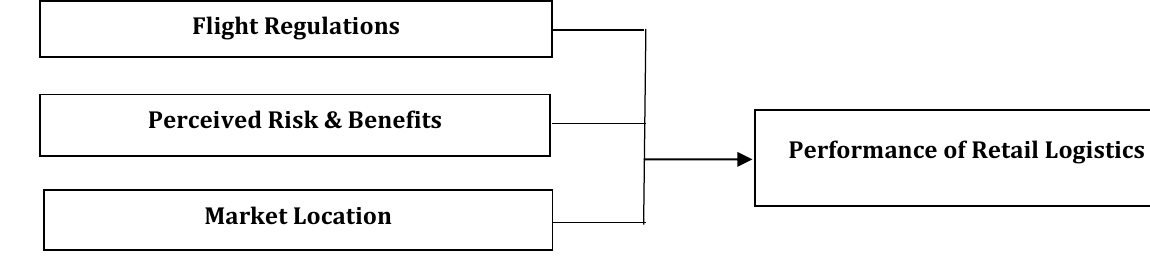
Figure 1: Suggested cause and effect relationship Flight